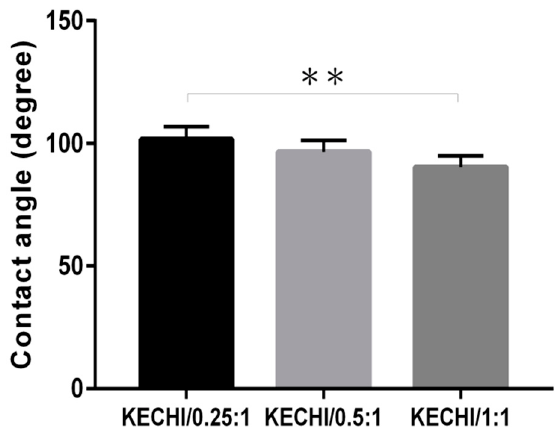
Figure 4. Quantification of contact angle of KECHI/0.25, KECHI/0.5, and KECHI/1:1. ** p < 0.01 .